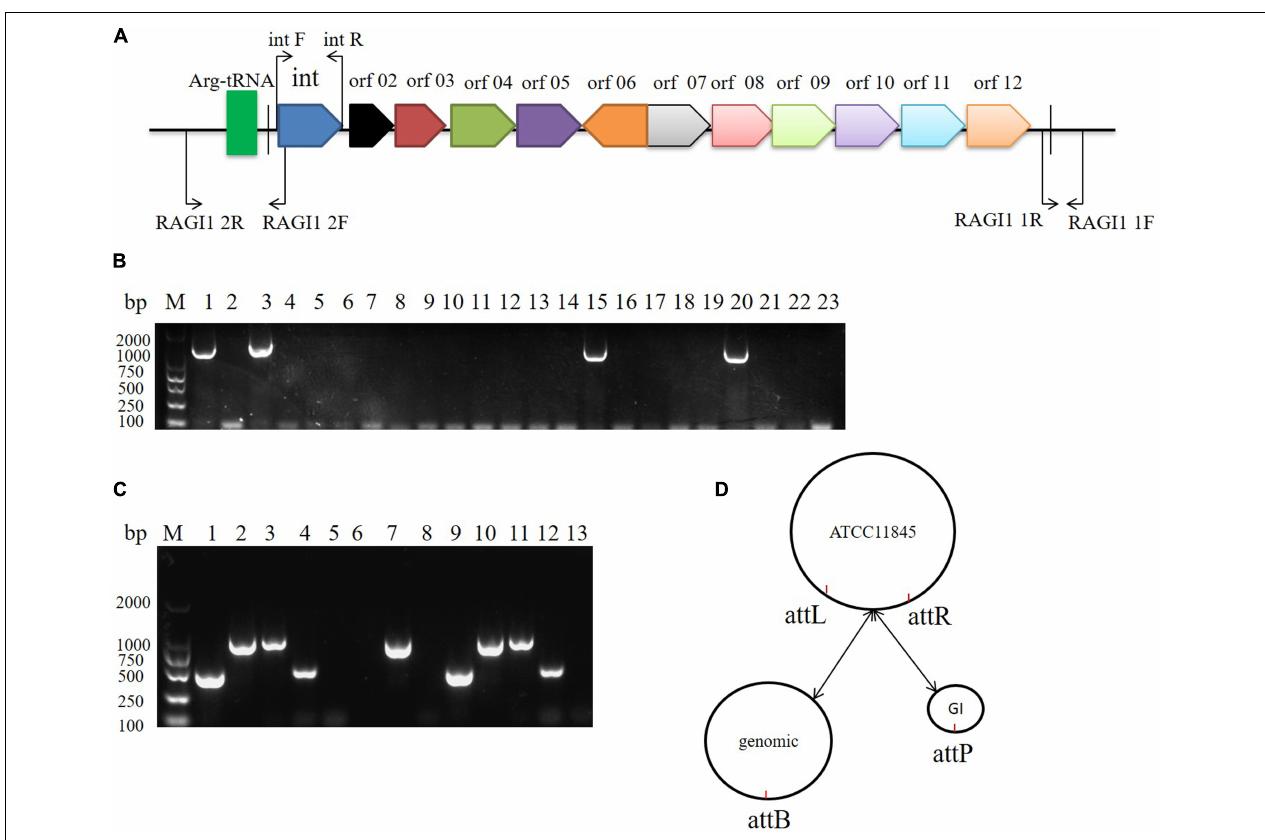
FIGURE 2 | 10K genomic island integration and excision in R. anatipestifer . (A) Primer designed for detecting of 10K GI, integration and excision. (B) Detecting of 10K GI in R. anatipestifer clinical isolated strain with primer pair int1 F/R. Lane 1, R. anatipestifer ATCC11845 strain; Lane 2, R. anatipestifer RA-YM strain; Lane 3–22, 20 clinical isolated strains No. 1–20; Lane 23, negative control. (C) Detecting of genomic island integration and excision, M: DL2000 DNA marker. Lane 1, DNA fragment was amplified with RAGI1 1F/1R primer pair from R. anatipestifer ATCC11845; Lane 2, DNA fragment was amplified with RAGI1 2F/2R primer pair from R. anatipestifer ATCC11845; Lane 3, DNA fragment was amplified with RAGI1 1F/2R primer pair from R. anatipestifer ATCC11845; Lane 4, DNA fragment was amplified with RAGI1 2F/1R primer pair from R. anatipestifer ATCC11845; Lane 5–8, DNA fragment was amplified with same primer from R. anatipestifer RA-YM; Lane 9–12, DNA fragment was amplified with same primer from R. anatipestifer clinical isolated strain No.1. Lane 13, negative control. (D) 10K GI integration and excision model. The dynamic balance of 10K genomic island integration and excision in R. anatipestifer ATCC11845